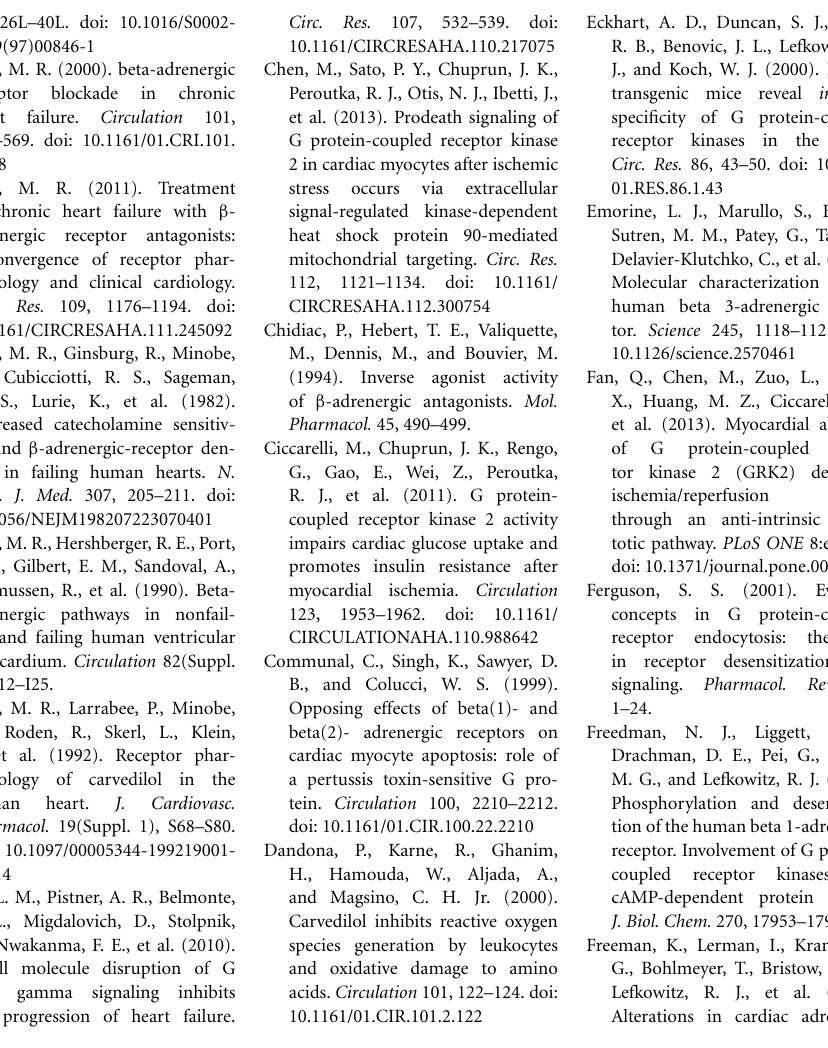
receptors; (2) β ARKct antagonizes GRK2 dependent phosphorylation of IRS1 increasing glucose uptake in myocytes; (3) β ARKct blocks the ischemia-induced mitochondria localization of GRK2 through inhibition of MAPK-dependent Hsp90 binding, inhibiting pro-apoptotic